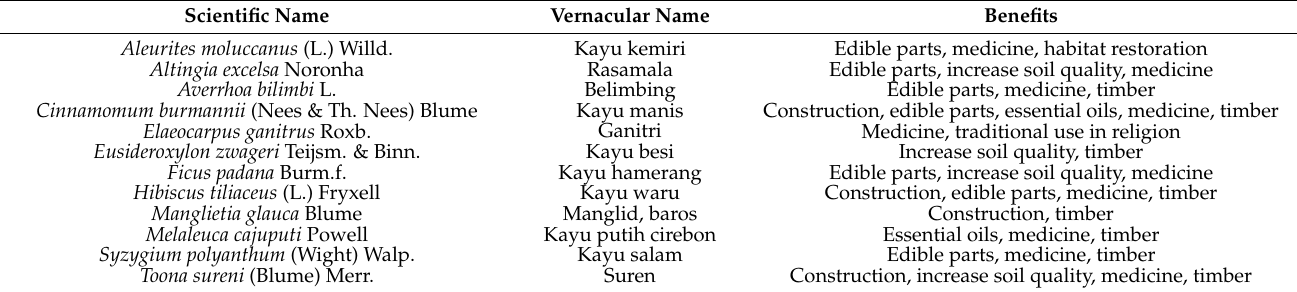
Table A1. List of shade trees that we suggested to the coffee farmers since native to the study area and with benefits for their crops and/or for the